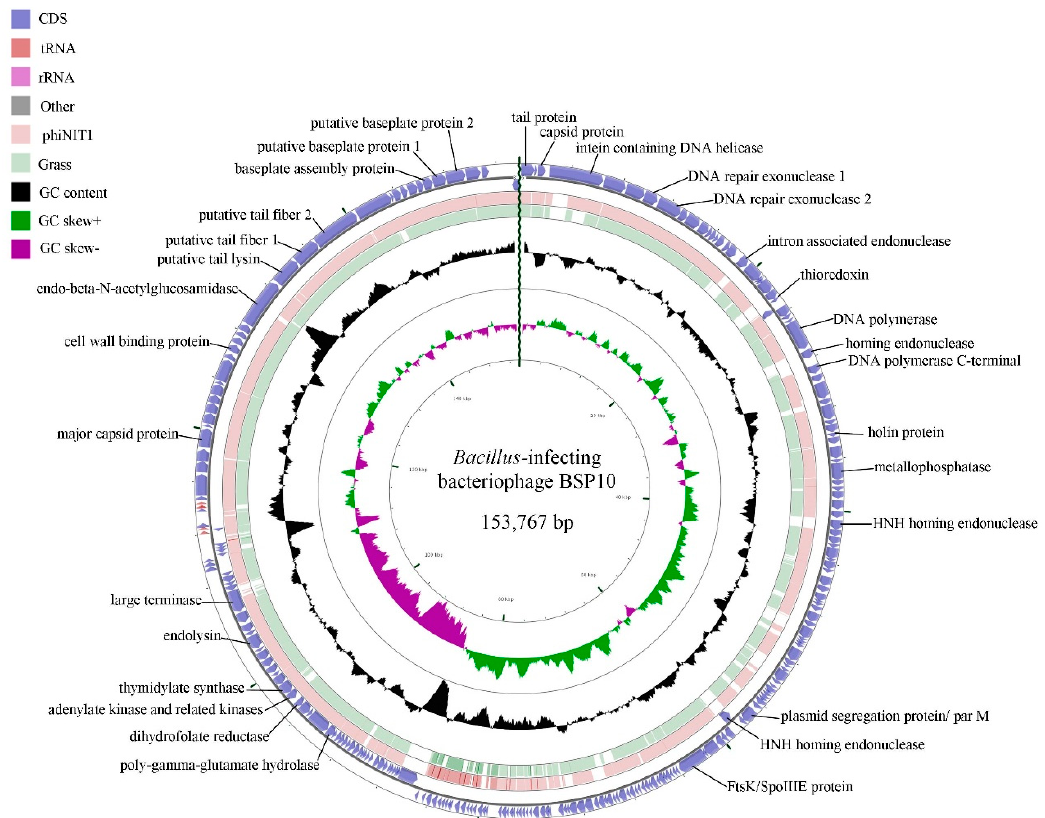
Figure 3. BLASTN genome comparison of bacteriophage BSP10 and the other members (phiNIT1 and Grass) of the genus, Nit1virus . The outer ring represents the ORFs of the bacteriophage BSP10 genome (blue). BLASTN homologies between bacteriophage BSP10 with phiNIT1 (light pink) and Grass (light green) were shown in the other two rings. Some major putative gene functions are labeled.